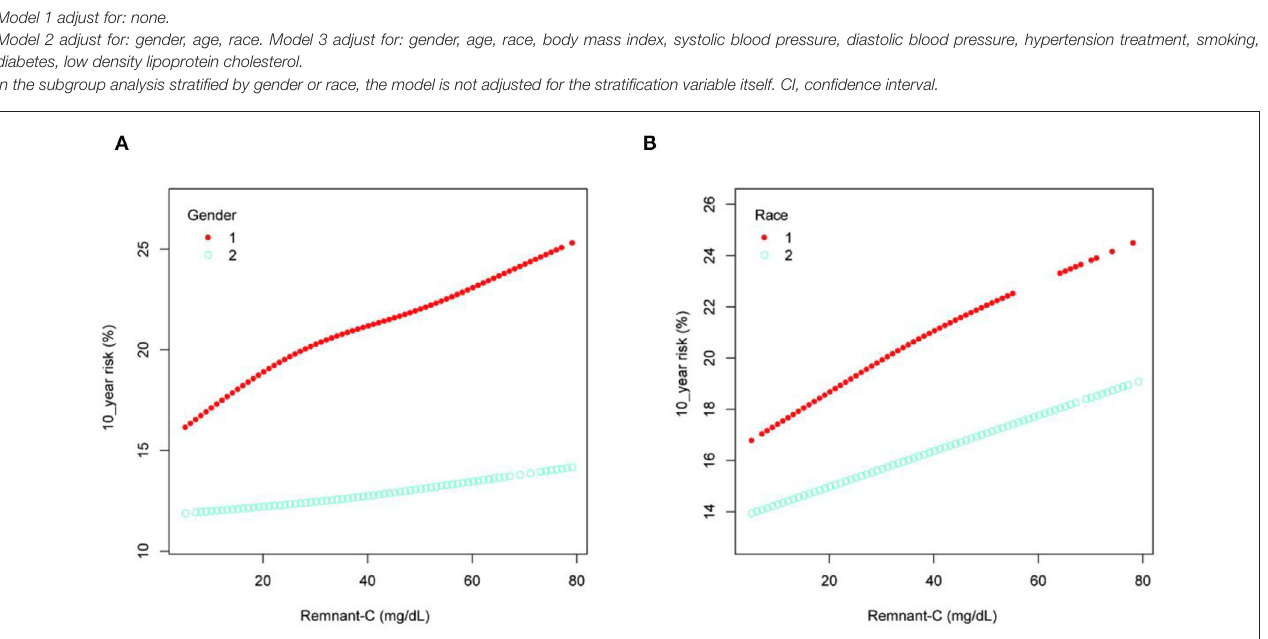
Model 1 adjust for: none. Model 2 adjust for: gender, age, race. Model 3 adjust for: gender, age, race, body mass index, systolic blood pressure, diastolic blood pressure, hypertension treatment, smoking,